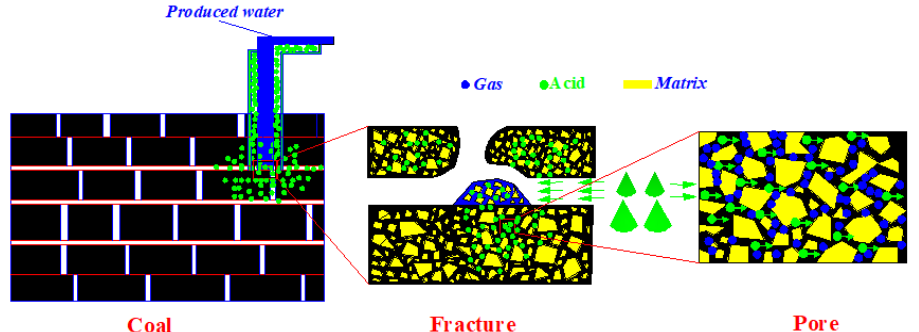
Figure 1. Reaction mechanism between acid and coal.